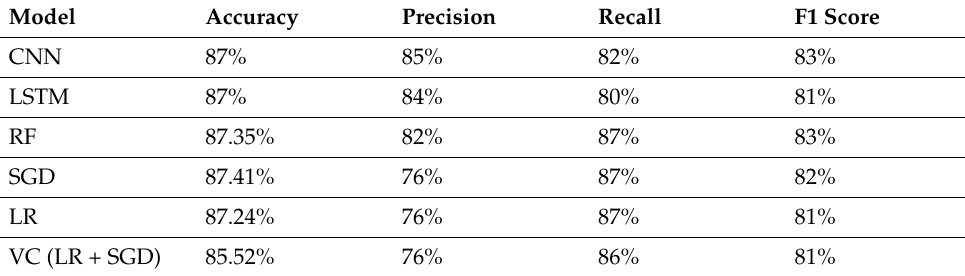
Table 4. Classification results of classifiers using fastText subword.